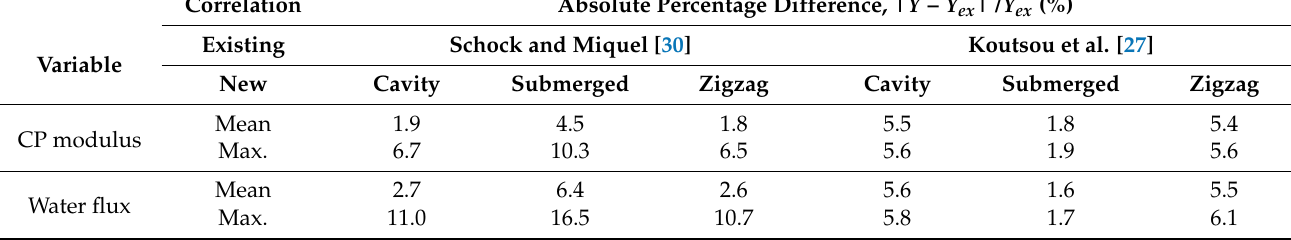
Table 4. Average and maximum absolute percentage difference between the new correlations and existing correlations for CP moduli and water